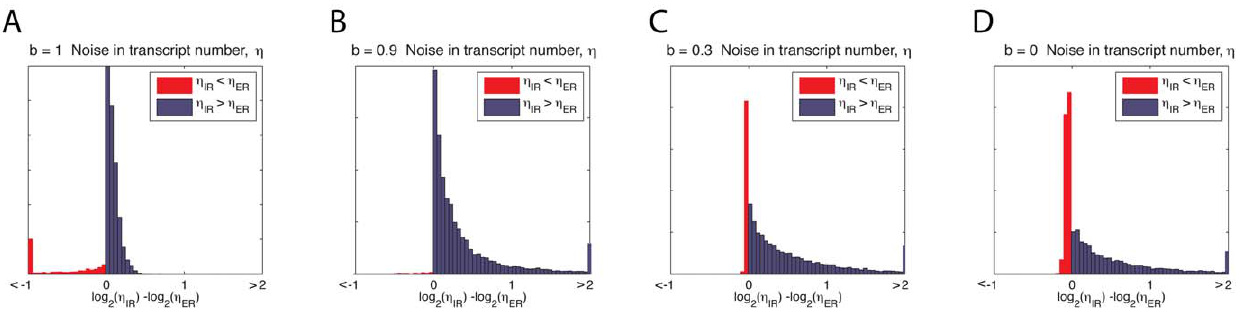
Figure 5. Effect of scaffold stability for variation in transcript number. ( A ) log 2 ratio of transcript variability, g , between the IR and ER model when all subsequent polymerases engage an assembled scaffold b ~ 1 . Extreme values that would be off the edge of the graph are collected into the outermost bins. ( B ) As in (A) when b ~ 0 : 9 , note the ER scheme is more often substantially more coordinated, though a few parameters still make the IR scheme the more coordinated by a smaller margin. ( C ) b ~ 0 : 3 . ( D ) b ~ 0